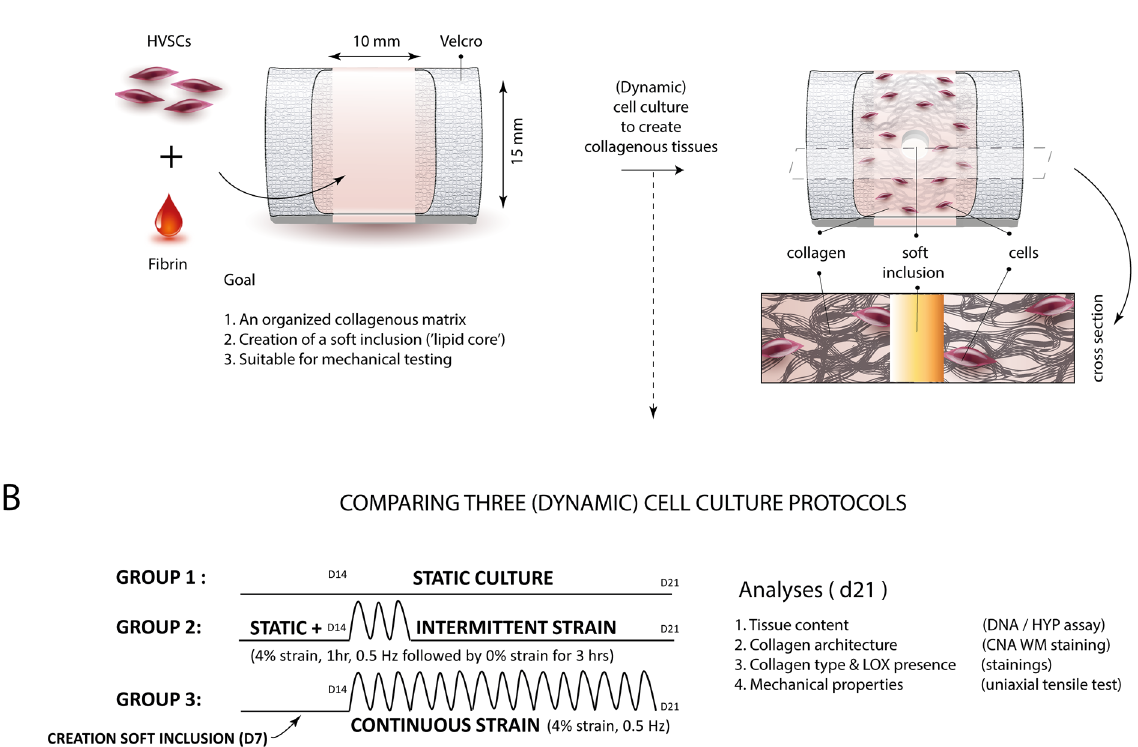
Figure 2. Graphical representation of the tissue engineered in vitro fibrous cap models generated. Collagenous tissues were generated by seeding HVSCs in fibrin gels between pares of Velcro strips and exposing them to three different (dynamic) cell culture protocols ( A ). More specifically, samples were first statically cultured for 14 days, whereafter they were exposed to another 7 days of static culture (group 1), 7 days of intermittent strain (group 2, i.e. alternating periods of straining (1 h, 4% strain) and rest (3 h)) or continuous strain (group 3, i.e. 4% strain). A soft inclusion was created at day 7 to mimic plaque heterogeneity. At day 21, samples were analyzed to determine cell number and collagen content, collagen architecture, collagen type, LOX presence and mechanical properties ( B ). HVSCs human vena saphena cells, HYP hydroxyproline, WM whole mount, LOX lysyl